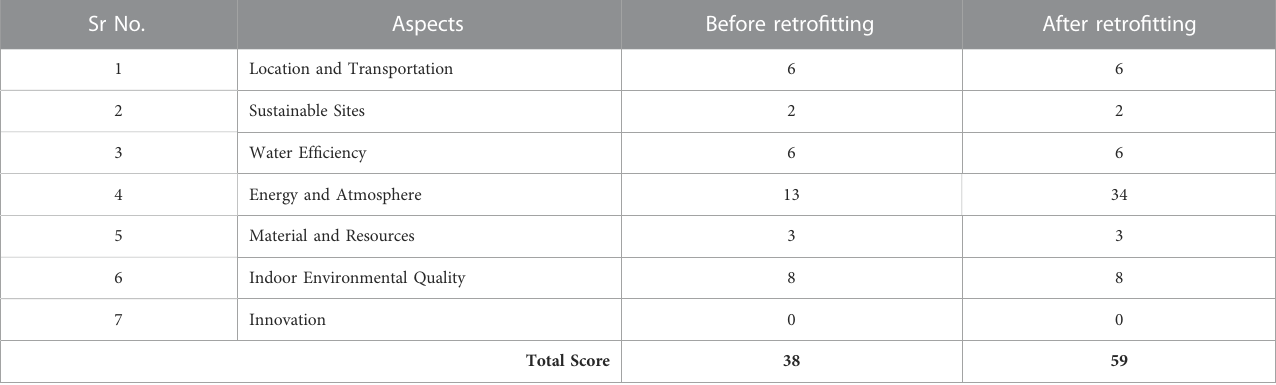
TABLE 7 Comparative rating of the building before and after retro fi tting. Sr